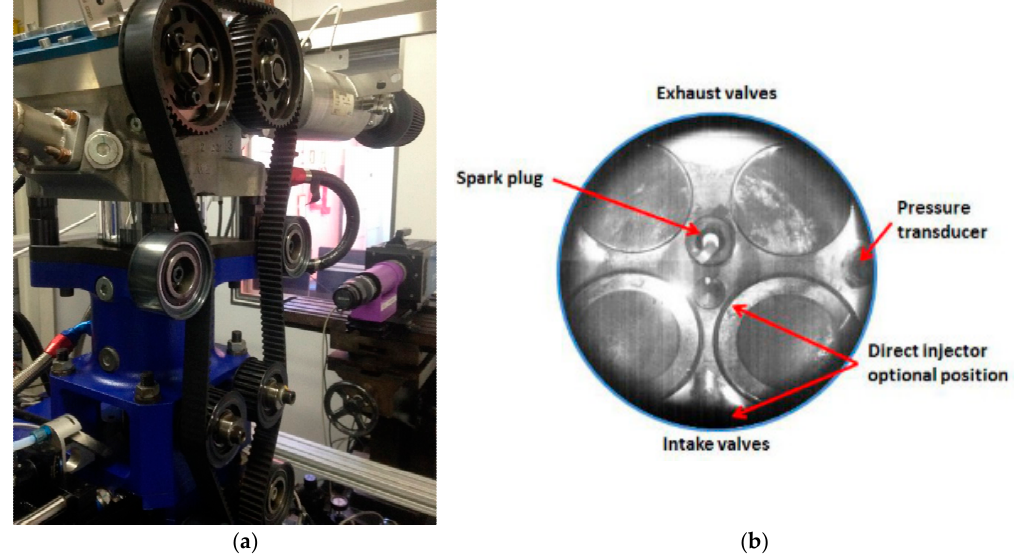
Figure 1. ( a ) Experimental setup of the single cylinder PFI-SI research engine with an optical arrangement (camera and intensifier), and ( b ) cylinder head bottom view.